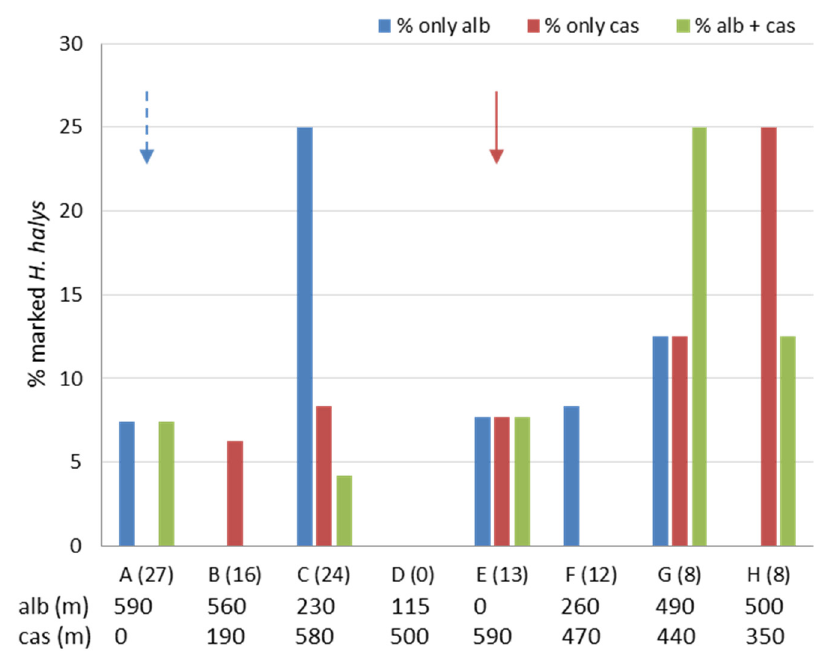
Figure 6. Total percentages of marked Halyomorpha halys adults collected in the sampling zones (A–H) of Area 2 from 26 April to 5 June. On the x-axis for each zone the total number of tested specimens is given in brackets. For each zone, the distance (meters) from the treatment site is also indicated either for albumin (“alb”) or casein (“cas”). Arrows designate the zones in which treatments with casein (dashed dark red arrow) and albumin (blue arrow) were applied.